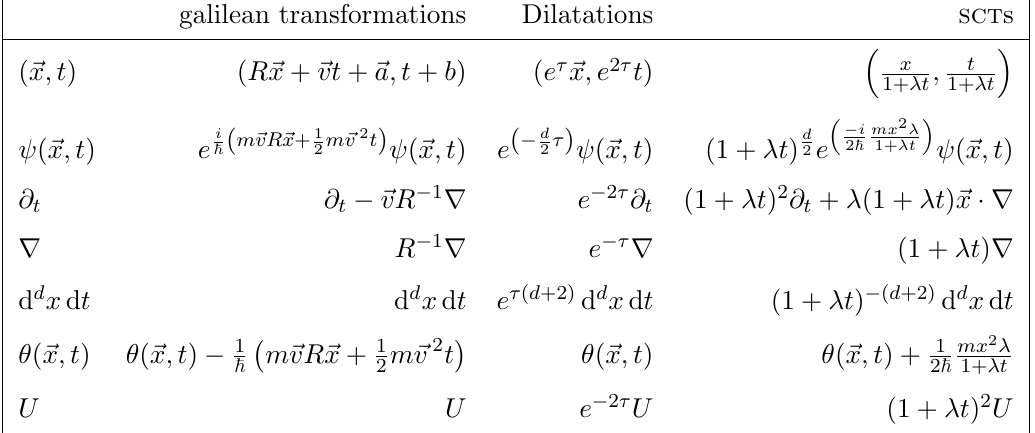
Table 1 . Summary of the transformations under the Schr(cid:127)odinger group in d space dimensions. It is also convenient to decompose the complex (cid:12)eld into its radial and angular